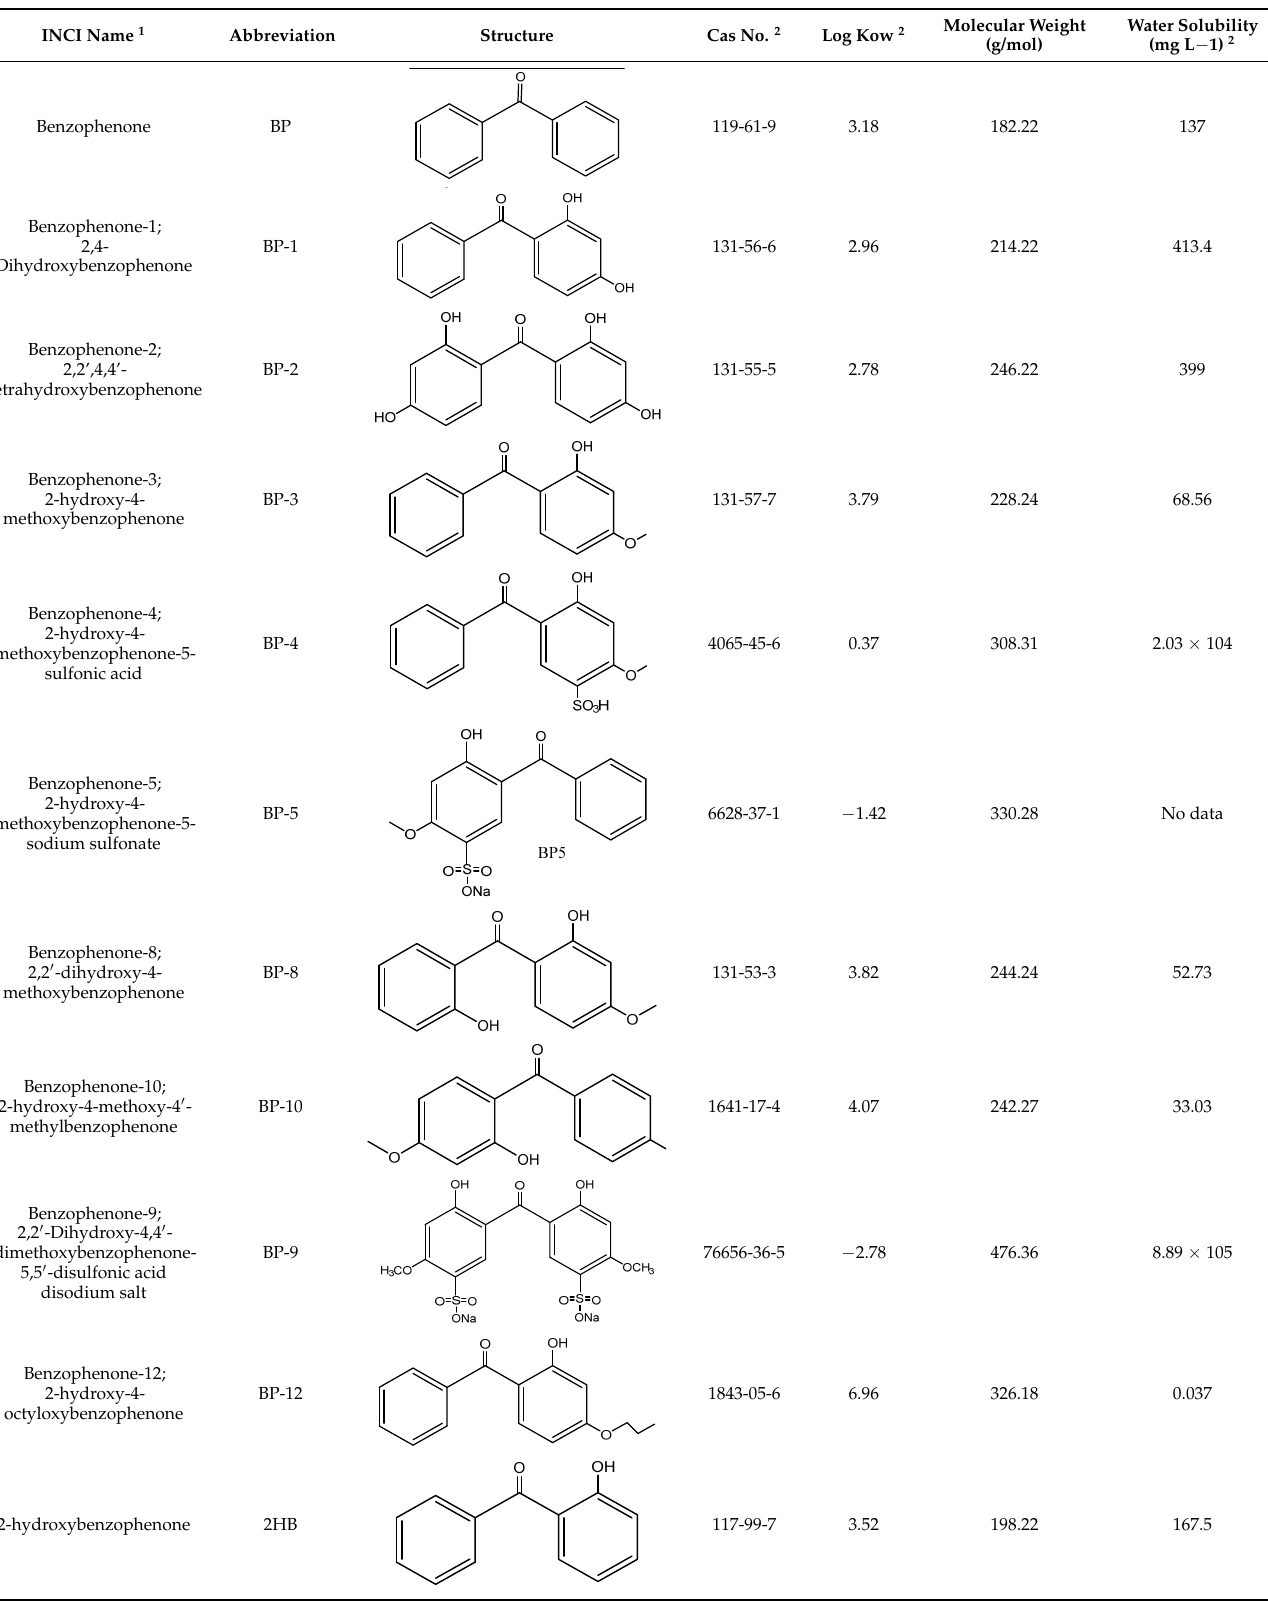
Table 2. Structures and properties of benzophenone-type UV filters [16].